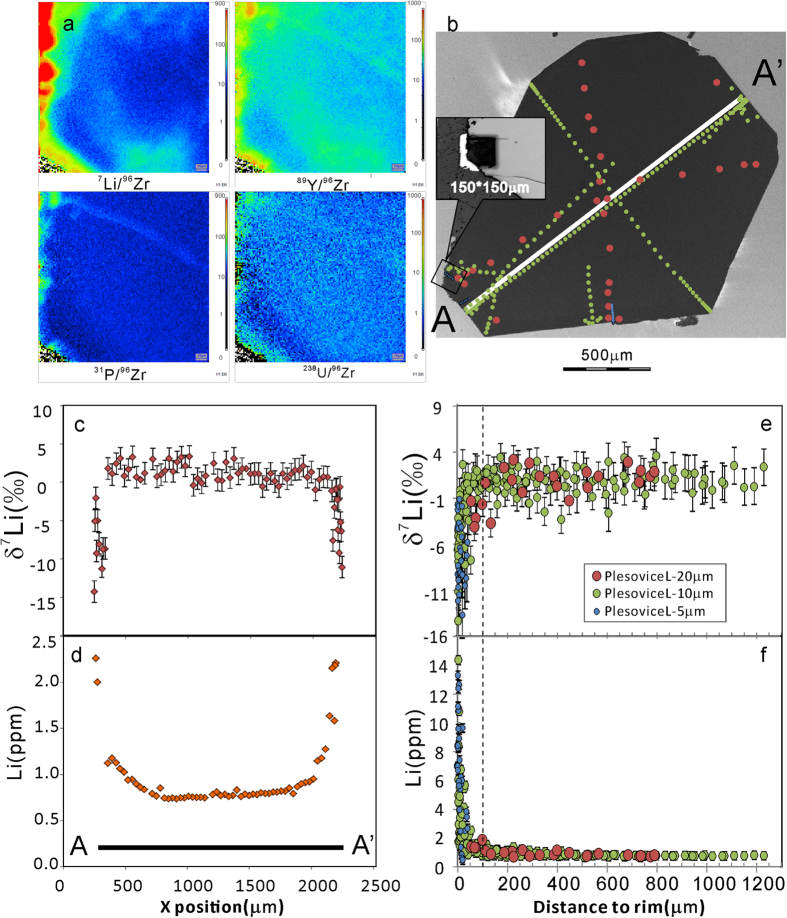
(a) Ion image of the variation of Li, Y, P and U content of Plešovice-L. (b) Trace outlines on the CL image to show the position of the Li isotopic and [Li] measurements. (c) δ7Li vs X position of AA’ profile. (d) [Li] vs X position of AA’ profile. (e) δ7Li vs relative distance to the rim. (f) [Li] vs relative distance to the rim.